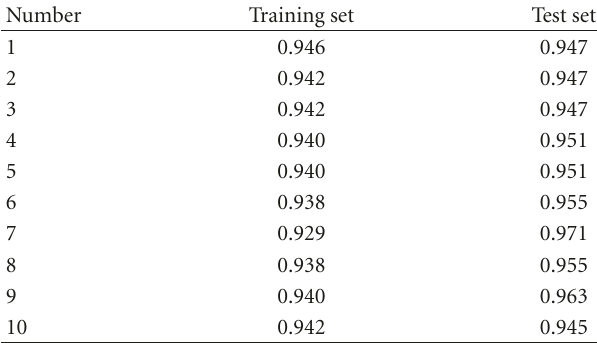
Table 6: Accuracy for the 10 pairs of training and test sets (One correlation case).